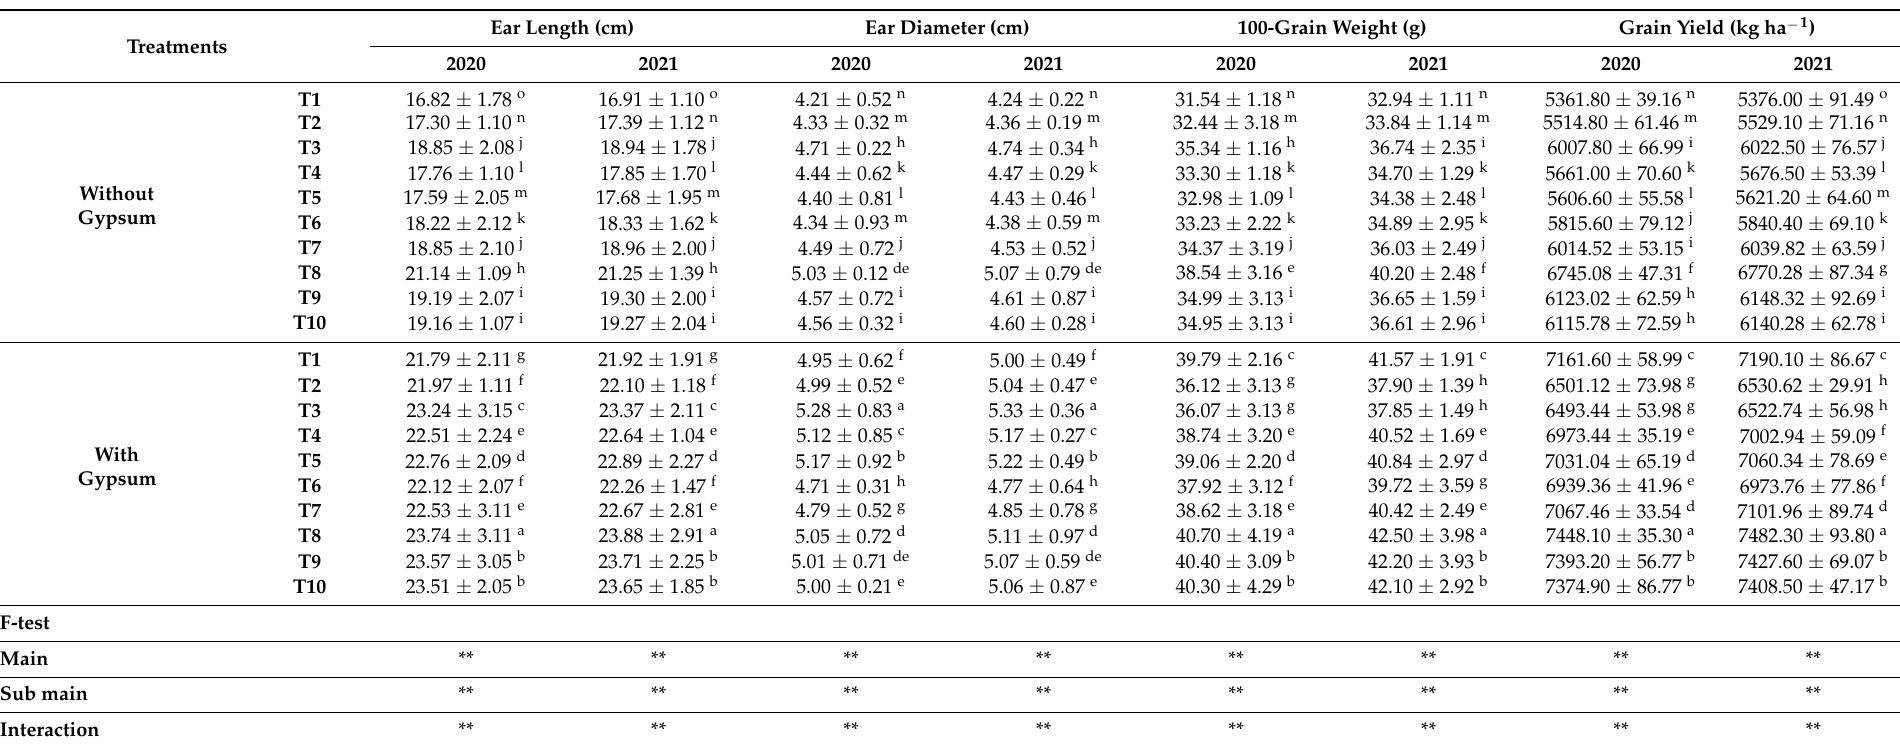
Table 7. Combined effects of gypsum and bio-priming with PGPR and different levels of chitosan (0, 25, 50, 75, and 100 mg L − 1 ), on yields and yield components of maize plants during 2020 and 2021